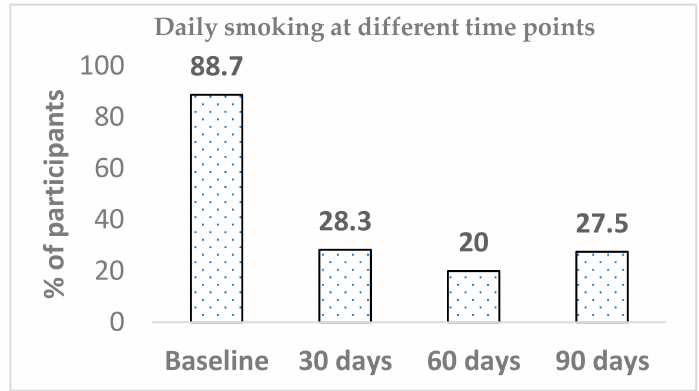
Figure 2. Prevalence of daily